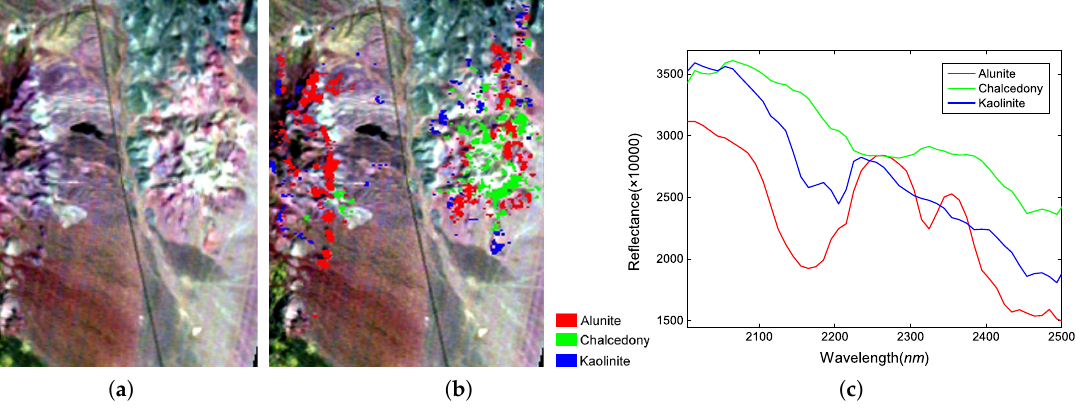
Figure 10. Hyperion hyperspectral data acquired at Cuprite Mining District: ( a ) false-color image (R: band 194 (2092.8 nm), G: band 204 (2193.7 nm ), and B: band 218 (2335.0 nm)); ( b ) reference mineral map for Alunite, Chalcedony, and Kaolinite of ( a ); ( c ) reference spectral signatures for Alunite, Chalcedony, and Kaolinite.